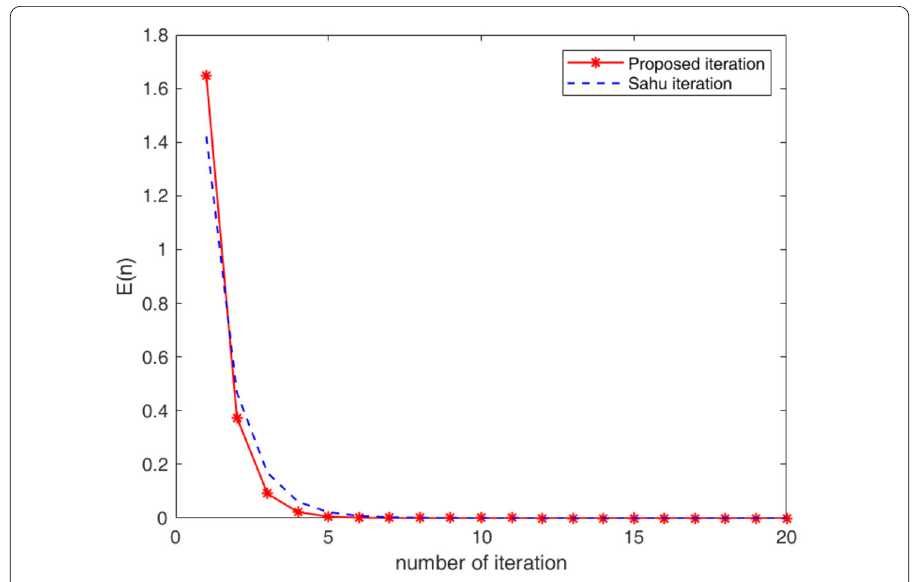
Figure 1 E ( n ) = (cid:16) χ n – χ n +1 (cid:16) for iterations with initial point (–3,1,2)